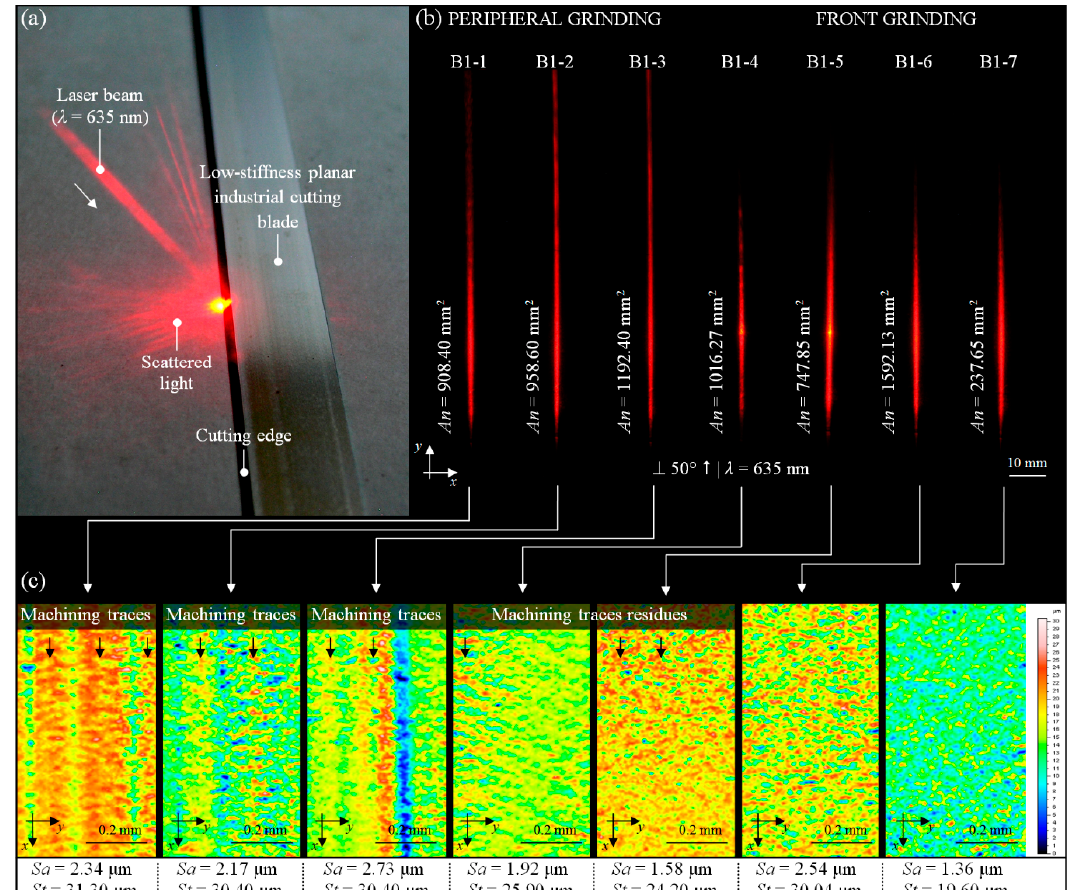
Figure 9. Collection of selected results of experimental studies obtained for cutting edge of the planar cutting blades: ( a ) regenerated sample B1-5 illuminated by a laser beam ( λ = 635 nm); ( b ) acquired images of the angular distribution of scattered light intensity (B1-1–B1-7) with calculated average values of the area using Image Pro ® -Plus 5.1 (Media Cybernetics Inc., Rockville, MD, USA) software; ( c ) corresponding with images from Figure 9b, the 2D surface maps obtained on the basis of of measurement data from a multisensory optical profilometer Talysurf CLI2000 (Taylor-Hobson, Leicester, Great Britain) with calculated amplitude (surface) parameters.